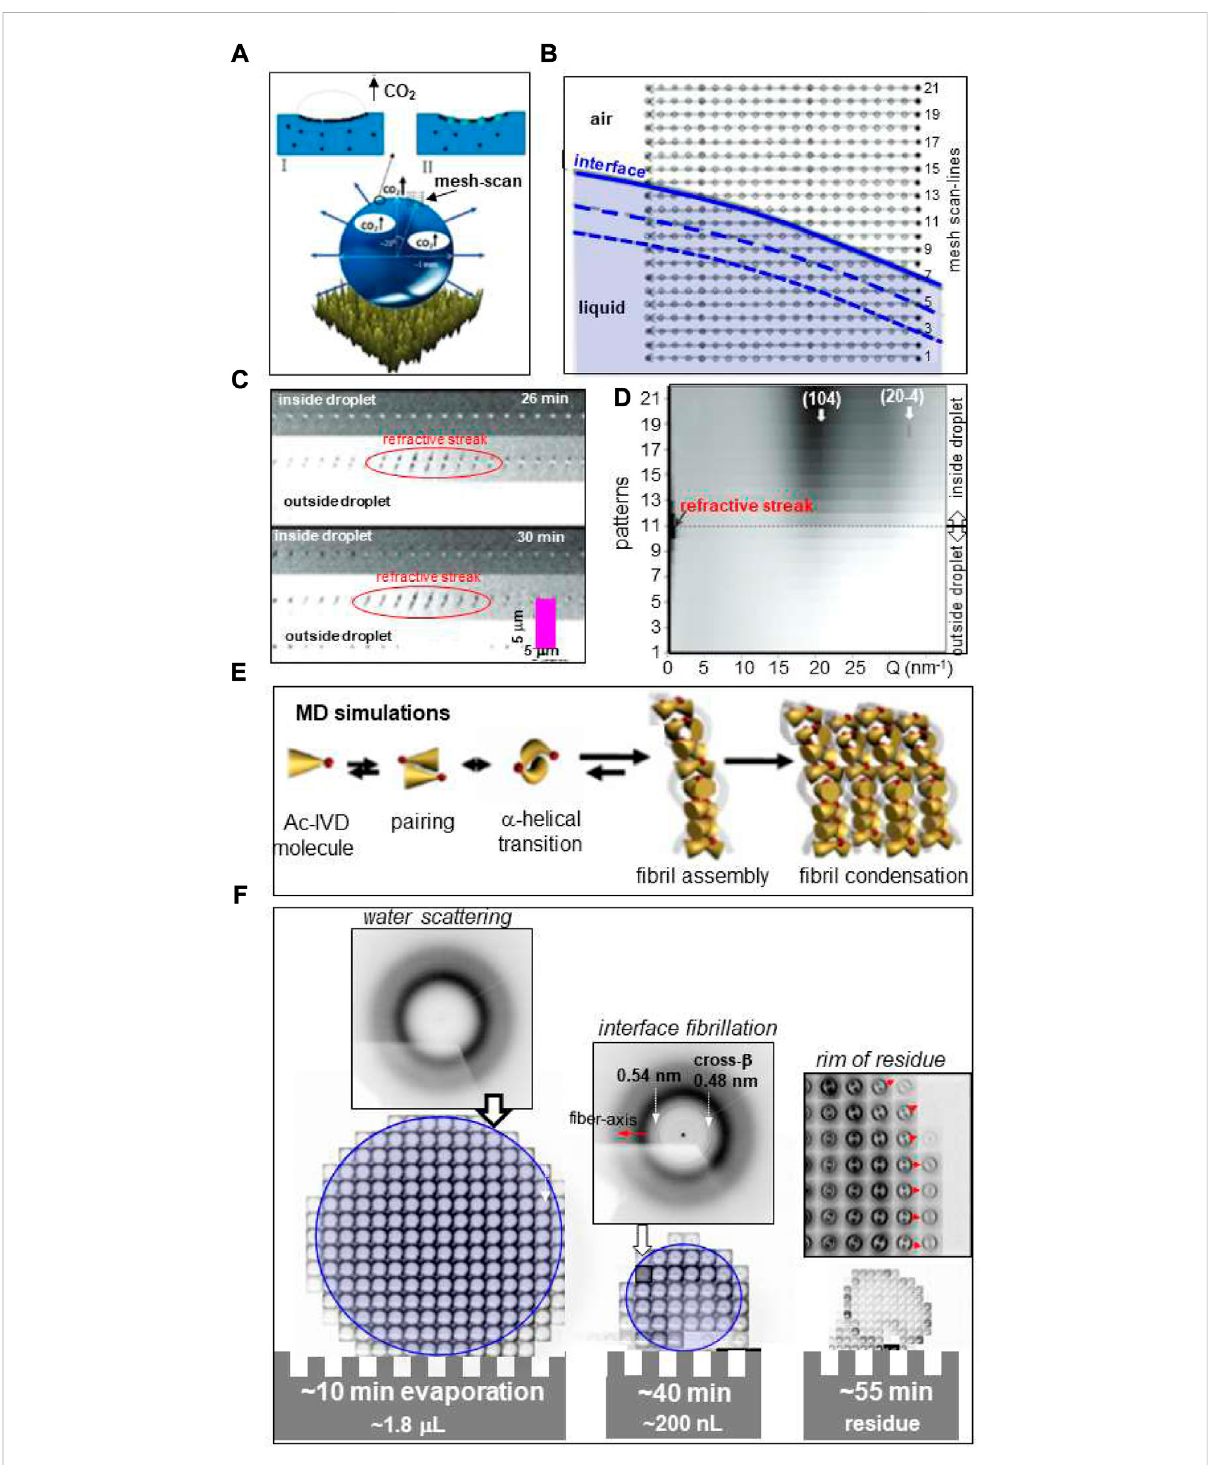
FIGURE 5 (A) Schematic picture of evaporating Ca(HCO 3 ) 2 solution droplet on PMMA surface showing surface accumulation of CaCO 3 and evaporating CO 2 bubbles. (B) Mesh-scan with 21 linear scan-lines of retracting droplet liquid/air interface through 1.7 μ m focal spot with 0.5 s/frame. The interfaceatthestartofevaporationisschematicallydepictedassolidblueline.Thedashedbluelinesindicatechangesoftheinterfaceatt=20/40 s. (C) Three scan-lines through interface area at two evaporation times with 0.1 s/frame. The refractive streaks indicate the position of the liquid/ air interface. (D) Co-existence of diffuse scattering from amorphous CaCO 3 and re fl ections of calcite at 26 min after start of evaporation. (E)